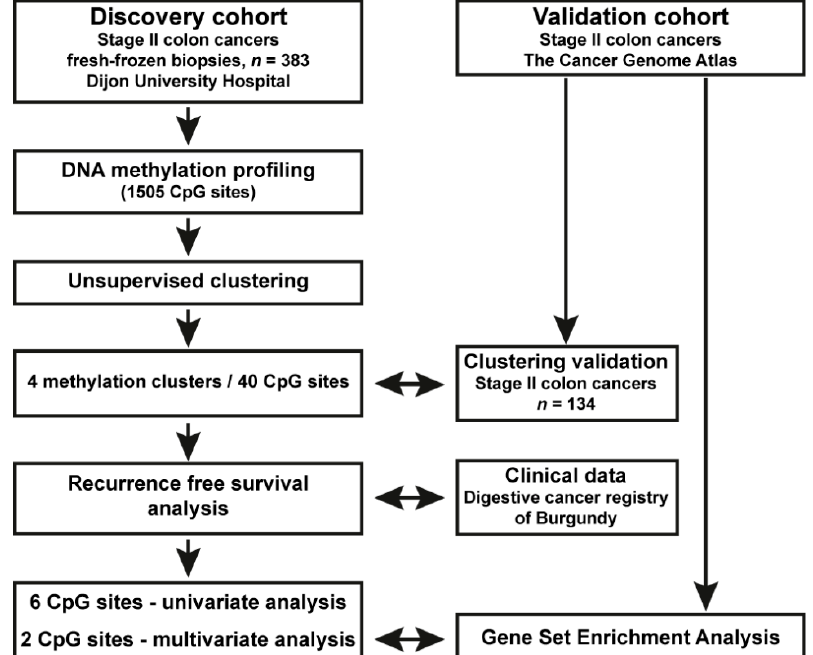
Figure 1. Study design. Scheme of the study design and key results. A discovery cohort composed of 383 fresh-frozen biopsies, from stage II colon cancer patients treated at Dijon University Hospital and registered in the Burgundy digestive cancer registry were selected for DNA methylation screening followed by unsupervised clustering analysis to uncover novel disease entities and DNA-methylation-based biomarkers for disease recurrence. By this strategy, we identified 40 CpG sites that could classify stage II CC into four disease clusters. By recurrence free survival analysis, two CpG sites in the CDH17 and LRP2 genes, respectively, were found to be significantly associated with probability of disease recurrence. A validation cohort was defined using stage II CC patient data from the Cancer Genome Atlas project (TCGA) (DNA methylation array and RNA-seq) ( n = 134; 116 tumour and 18 adjacent normal tissue samples). By this approach, the CpG classifier could be independently validated, and functional and immune cell analyses could be performed, according to the methylation status of the 2 CpG sites of interest at the CDH17 and LRP2 , respectively (see text for details). Table 1. Clinical and molecular characteristics of the stage II colon cancer population-based discov- ery cohort.